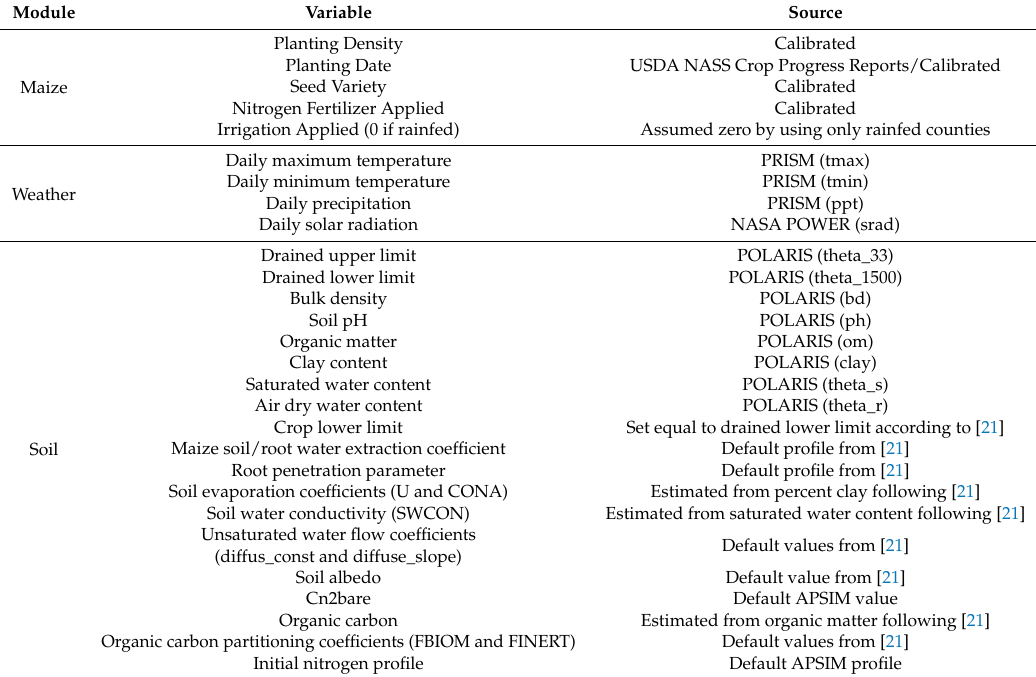
Table 1. Input variables used for APSIM